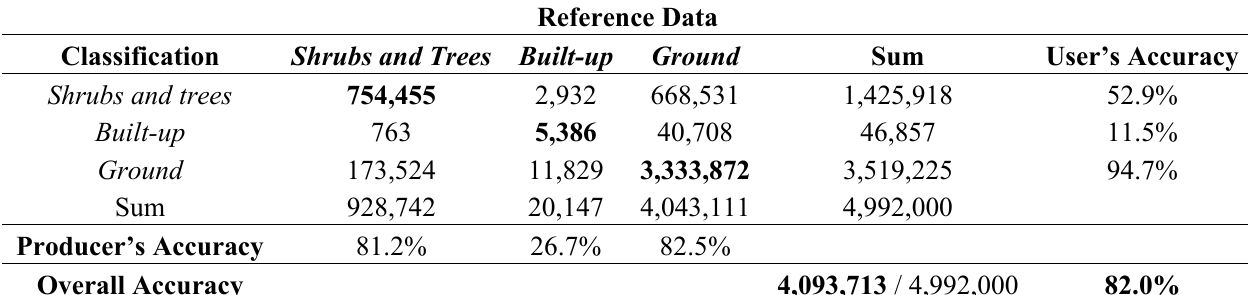
Table 6. Confusion matrix and accuracy estimates for the classification based only on the CIR orthoimages and the four features derived from the CART analysis.